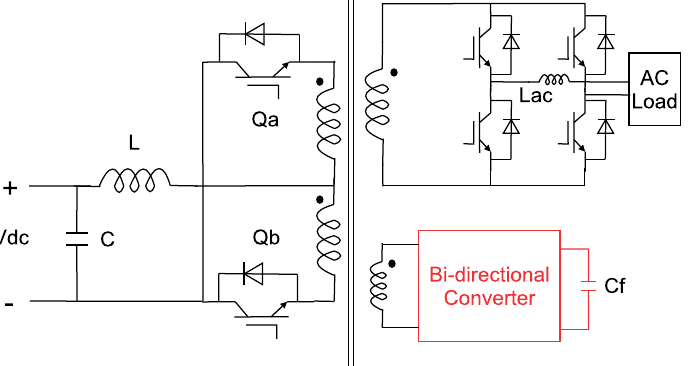
Figure 7. High-frequency flyback based utility interactive